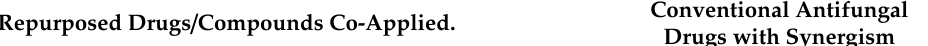
Table 5. Summary of the drugs and compounds exerting synergism during co-application (see also Table S1, Supplementary